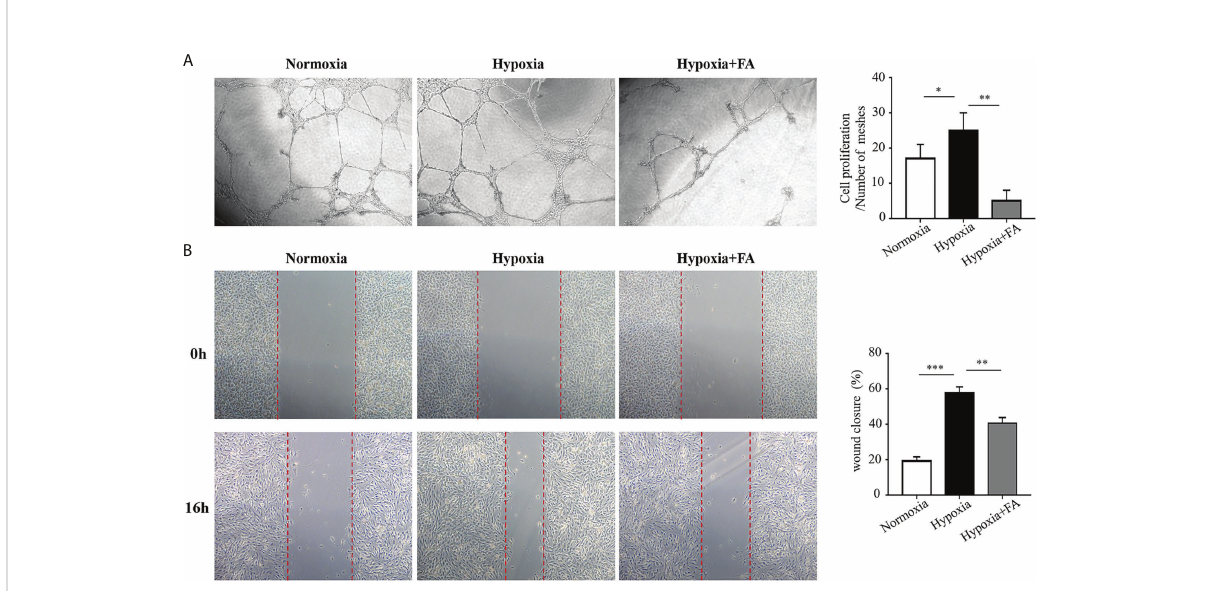
FIGURE 5 Conditional medium from FA-treated microglia inhibited tube formation and migration of human retinal endothelial cells (HRECs). BV2 microglial cells were cultured under hypoxic conditions (1.5% O 2 ) with or without FA treatment for 24 h The supernatants from BV2 cells were collected and applied to the culture medium of HRECs for 16 h (A) Tube formation assay showed that hypoxia-stimulated supernatants from microglia promoted tube formation, whereas FA-treated microglia-derived medium inhibited HRECs tube formation. (B) Wound healing assay showed increased percentage of wound closure rate in the hypoxia-cultured medium group, which was inhibited when FA-treated BV2-derived culture medium was added. Data are presented as mean ± SEM. * P < 0.05, ** P < 0.01, *** P <